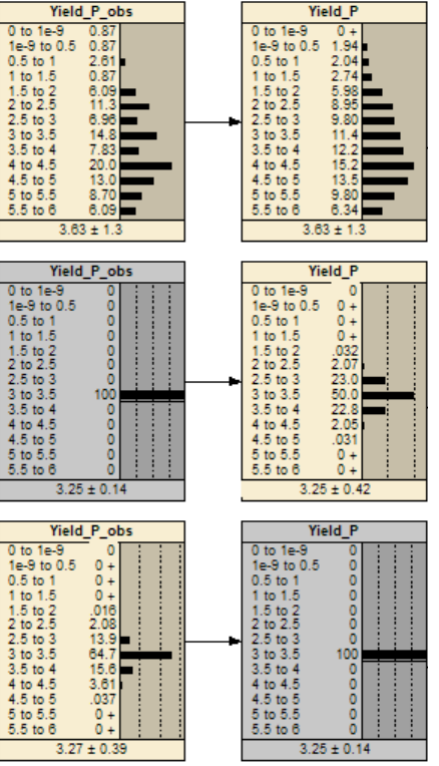
Figure A1.3: Details of forward and backward propagation of information in the BN in two selected nodes. The yellow boxes reflect the probability distribution of the node in the BN. The gray boxes reflect nodes that have been “instantiated”, that is, fixed or “given evidence”; any change to the probability distribution of a node is then forward- and back-propagated across nodes in the